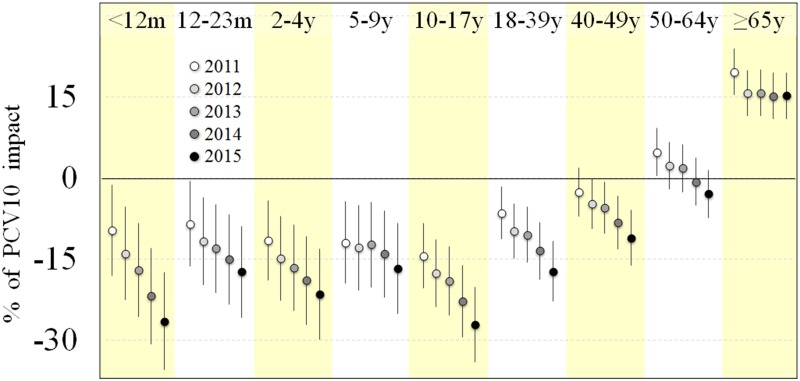
Annual relative percentage change on pneumonia hospitalizations by age-group in the post-vaccination period.Brazil, 2011–2015.